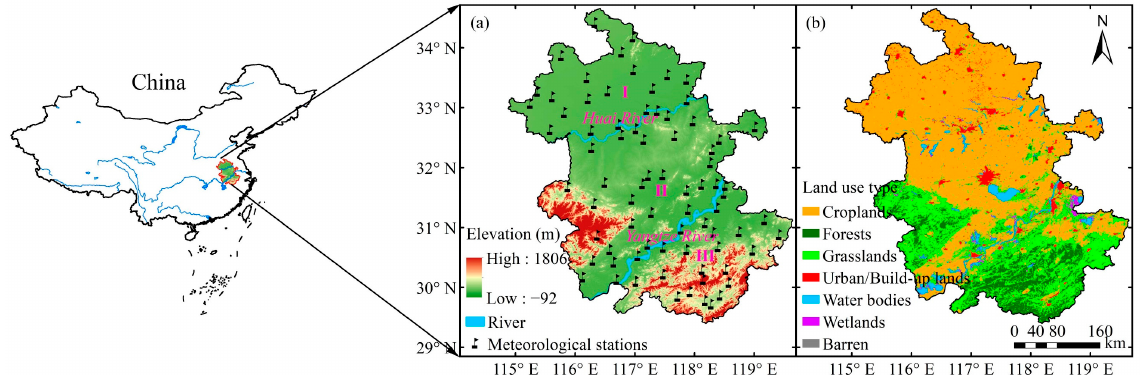
Figure 1. Location, elevation ( a ) and land use type ( b ) of Anhui province in China. Note: The Huai River and Yangtze River divide the Anhui province into three regions, namely, Regions I, II and III ( a ). The land use type dataset adopted here was MCD12Q1 of MODIS product in 2014, with the spatial resolution of 500 m × 500 m ( b ).